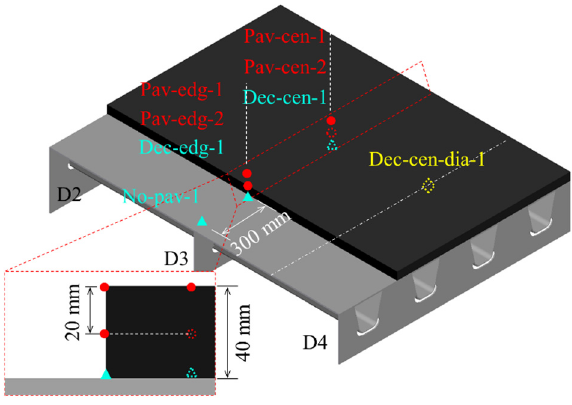
Figure 12. Arrangement of extracting points.